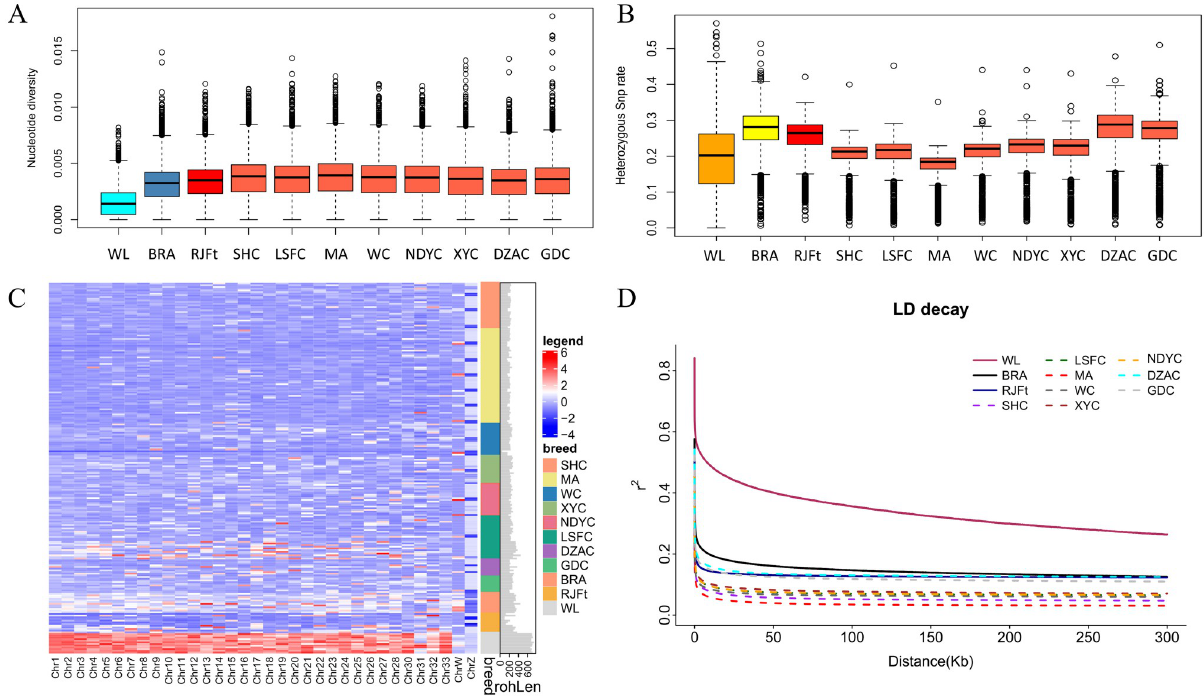
Fig 2. Genome diversity and LD decay of 11 chicken populations. (A) Genome nucleotide diversity was calculated with a window size of 40 kb and a step size of 20 kb. (B) Genome heterozygosity within 500kb sliding window across the genome. (C) The ROH of each chromosome in different breeds. The redder color represents longer ROH, the bluer the shorter. (D) Linkage disequilibrium (LD) decay, denoted with one line for each population.